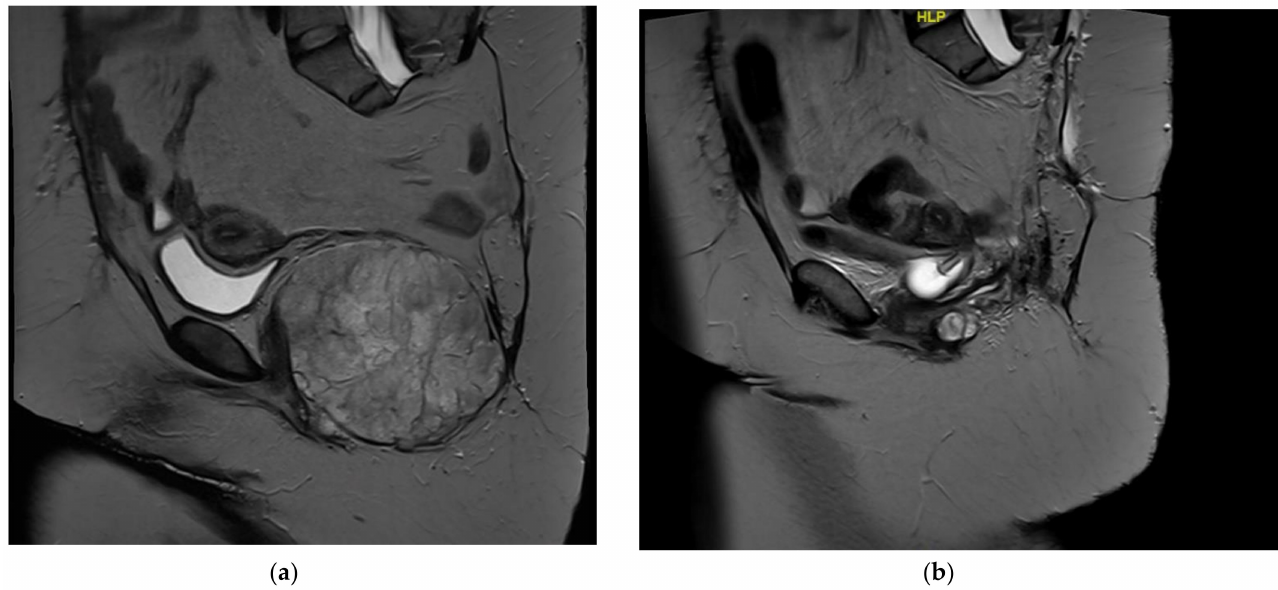
Figure 1. ( a ) Sagittal T2 MRI demonstrating a recurrent chordoma in the pelvic floor with evidence of prior sacrectomy. ( b ) Postsurgical sagittal T2 MRI demonstrating postsurgical changes after en bloc resection of chordoma requiring removal of the distal colon, rectum, and anus.